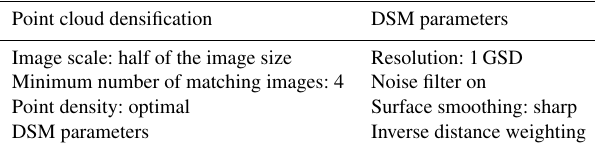
Table 3. Processing parameters set in Pix4D. Point cloud densification